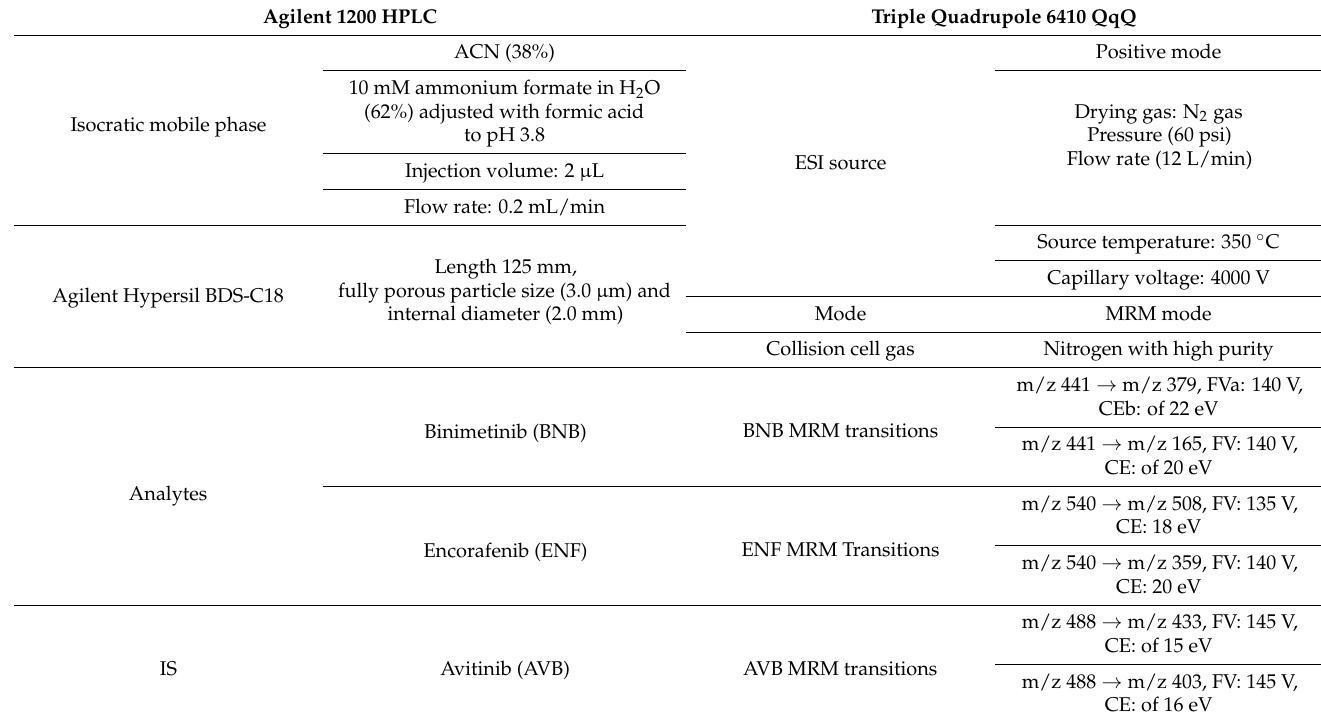
Table 6. LC–MS/MS methodology